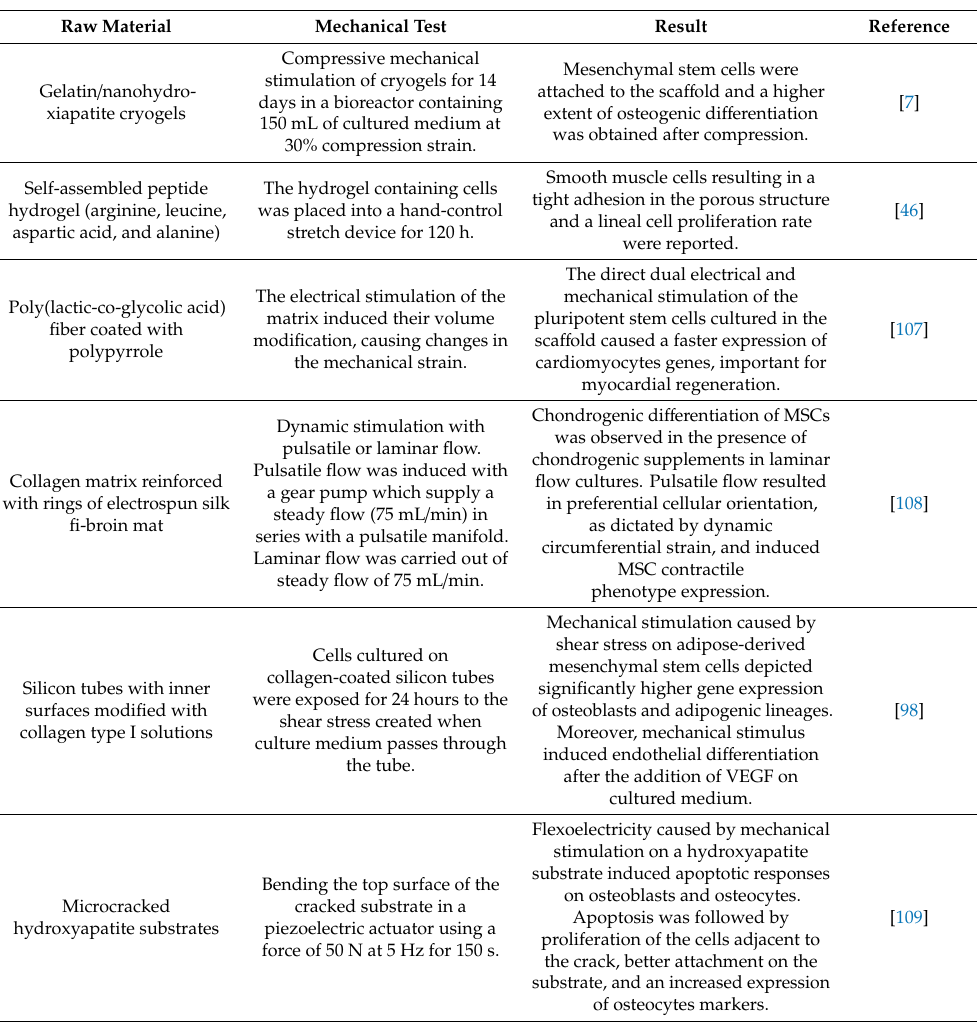
Table 2. Used methods to induce mechanical stimulation of cells in synthetic extracellular matrices